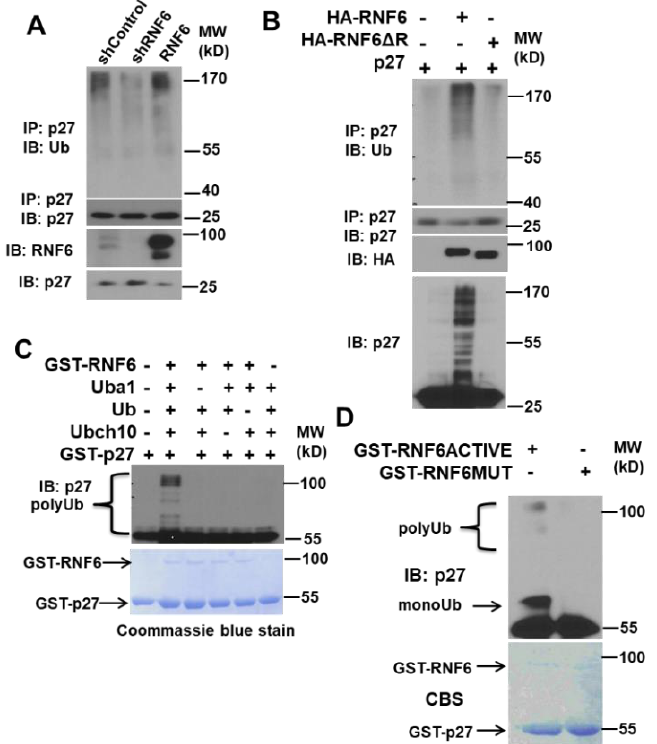
Figure 4. RNF6 ubiquitinates p27 in vivo and in vitro. ( A ) LNCaP cells were transduced with scram- bled shRNA, shRNF6, or RNF6 plasmid. After about 72 h of transduction, cells were lysed and ly- sates immunoprecipitated with anti-p27 antibody. Immunoprecipitates were then probed for Ub. ( B ) HEK293 cells were transfected with either p27 alone, WT-RNF6 and p27, or mutant RNF6 (ΔRING) and p27. After 4 2 h of transfection, cells were treated with MG132 for an additional 6 h. Cells were then lysed in denaturing buffer and lysates immunoprecipitated with anti-p27 antibody. The immunoprecipitates were immunoblotted for Ub. ( C ) The in vitro ubiquitination assays were carried out as described in Materials and Methods. Top, immunoblot of anti-p27 to detect p27. Bot- tom: Coomassie blue staining (CBS) of the gel to monitor the amount of E3 ligases present in the reactions. ( D ) Same as in C except that either active or inactive GST-RNF6 was used.